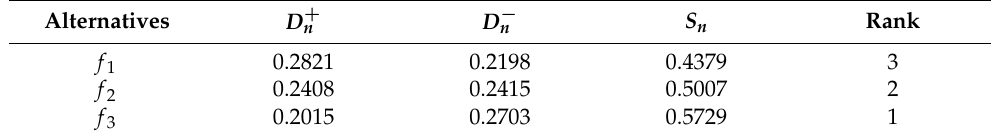
Table 5. Closeness coefficients and ranking of